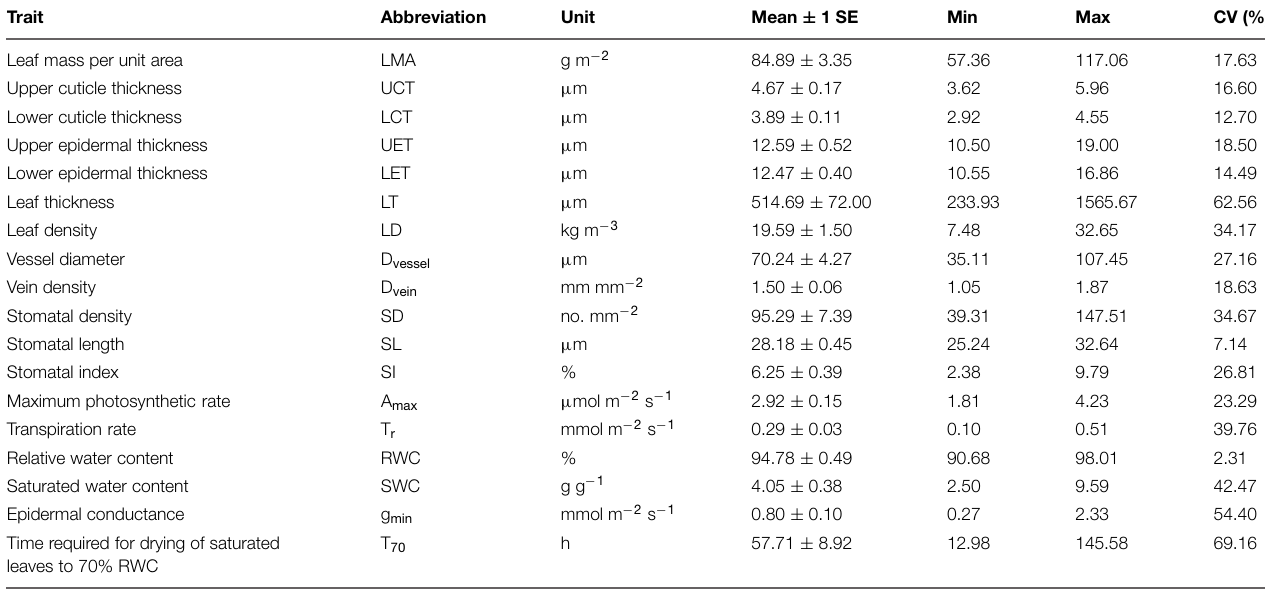
TABLE 1 | Quantification of leaf functional traits for tested Cymbidium species.